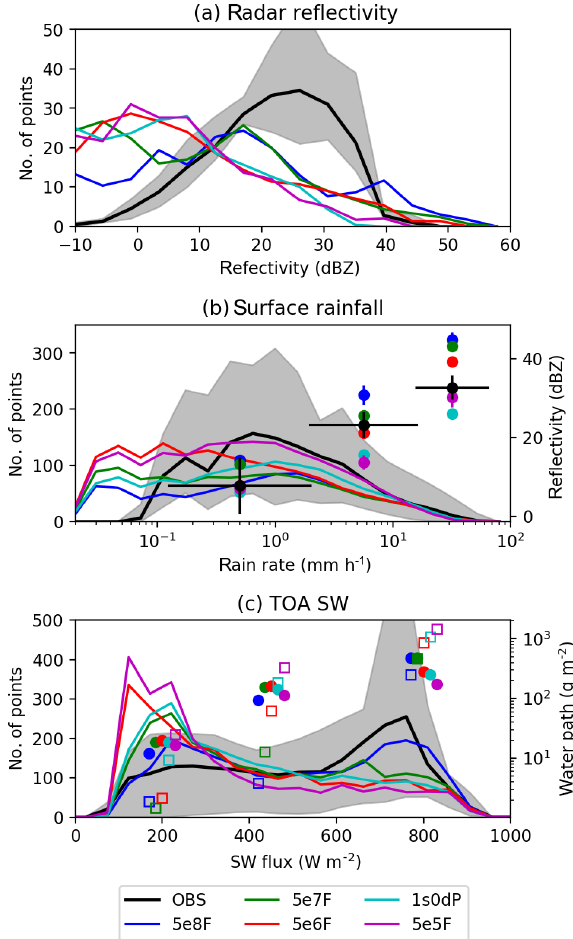
Figure 6. Time–mean histograms (solid lines) of (a) radar reflec- tivity, (b) the surface-rainfall rate and (c) outgoing SW flux in the model experiments compared to the observations. The grey shaded area shows the range (from the minimum to maximum number of counts) for the observations, in each variable bin. In panel (b) the coloured circles show the mean radar reflectivity in three surface- rainfall intervals for the simulations (colours) and IMERG retrievals (black). The horizontal bars on the IMERG points show the lengths of each intervals. In panel (c) the coloured symbols show the mean cloud-water paths (circles) and rainwater paths (squares) in three contiguous SW-flux intervals, for the